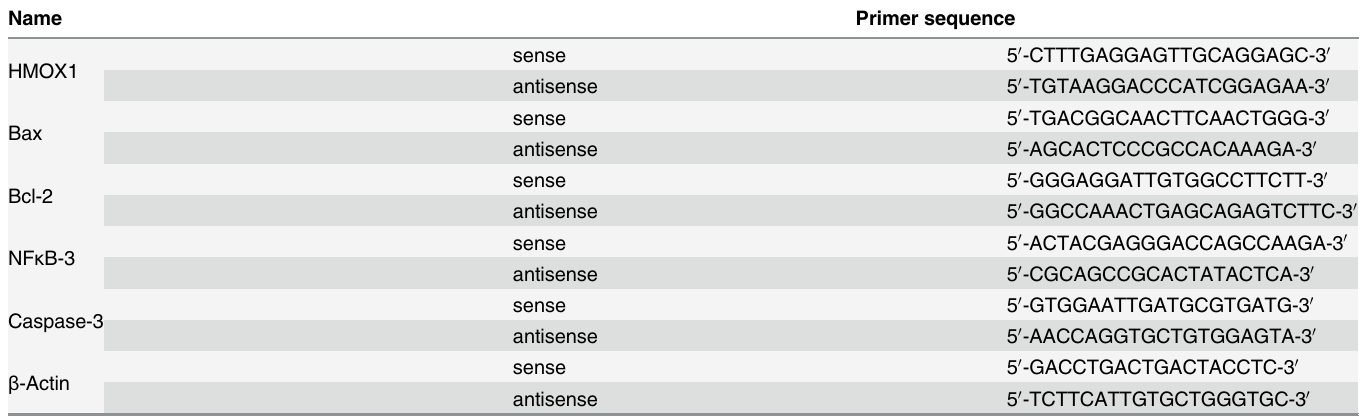
Table 1. Primer sequences for the apoptosis factors in RT-PCR.